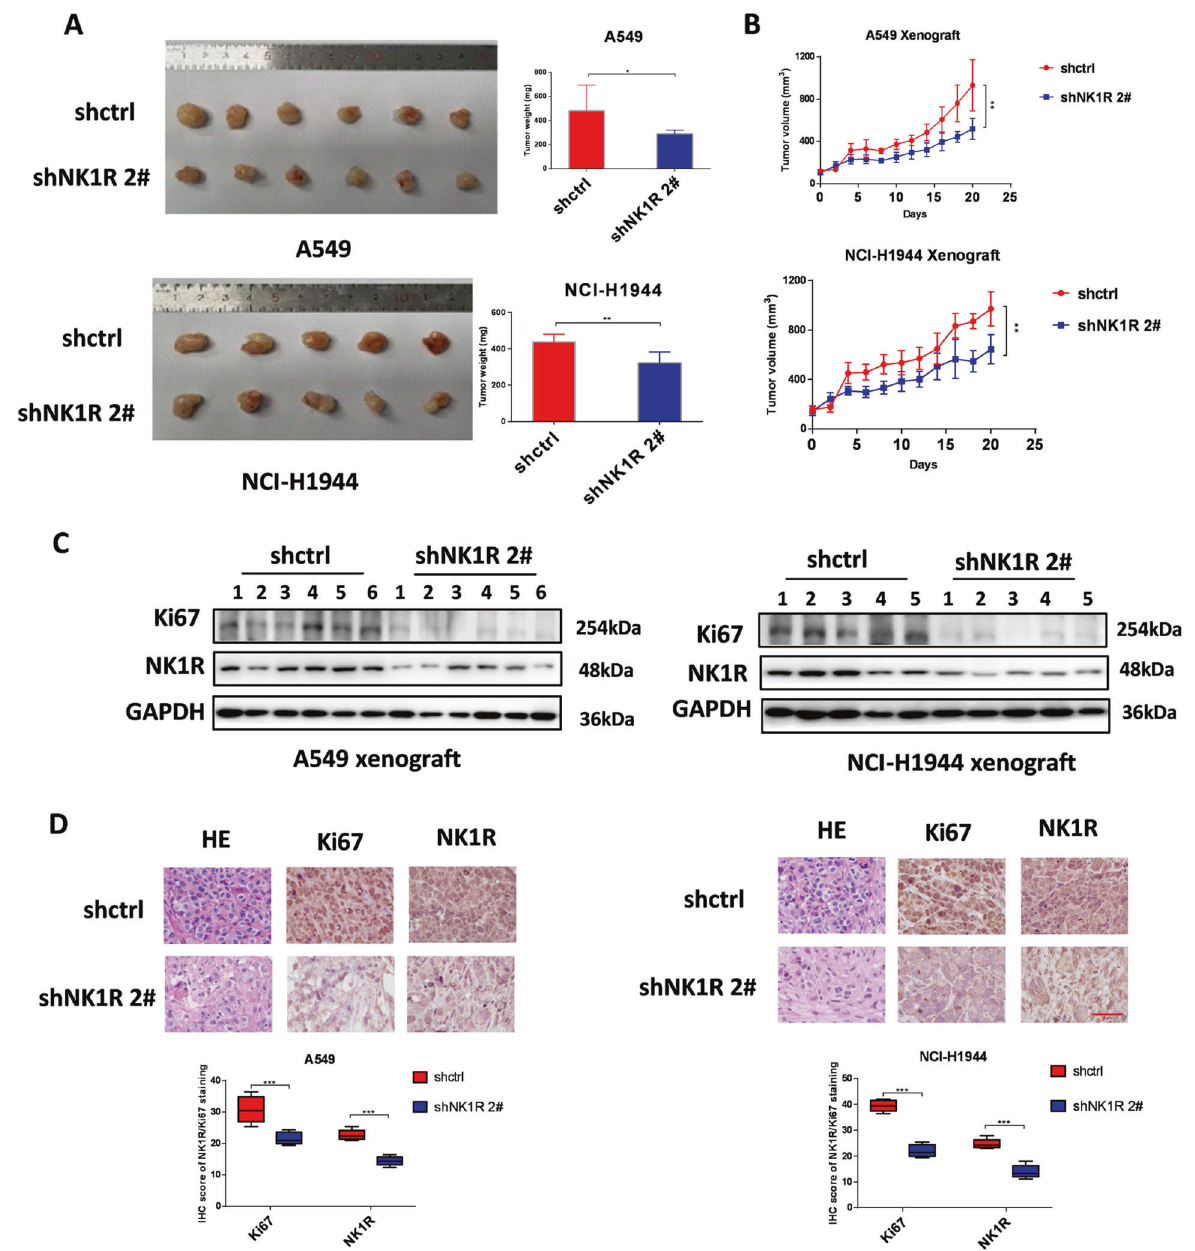
Fig. 4 Knockdown of NK1R impaired NSCLC tumor growth in vivo. A549 and NCI-H1944 cells were transfected with control or shNK1R plasmid. A , B The effect of NK1R knockdown on NSCLC tumor growth in nude mice. C Western blot and D IHC analysis of NK1R and Ki67 protein level in xenograft tumor samples. Scar bar, 50 μ m. The IHC staining and densitometric analysis of each band were calculated with Image J software. Data were shown as mean ± SD from three independent experiments. * P < 0.05, ** P < 0.01, *** P <